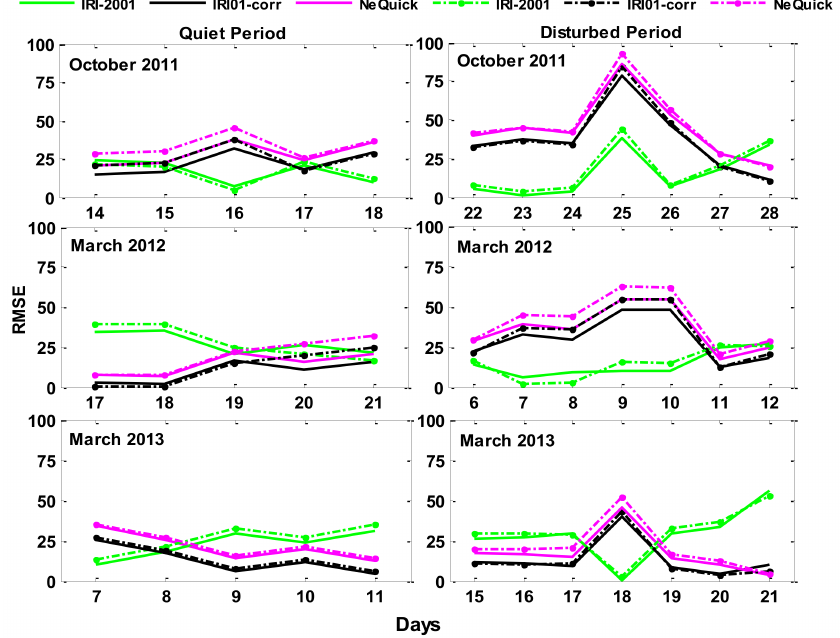
Figure 9. The daily RMSE values during quiet and disturbed periods. The IRI-2016 (IRI-2001, IRI01- corr, and NeQuick) are plotted in solid lines and the IRI-2012 (IRI-2001, IRI01-corr, and NeQuick) are plotted in dotted